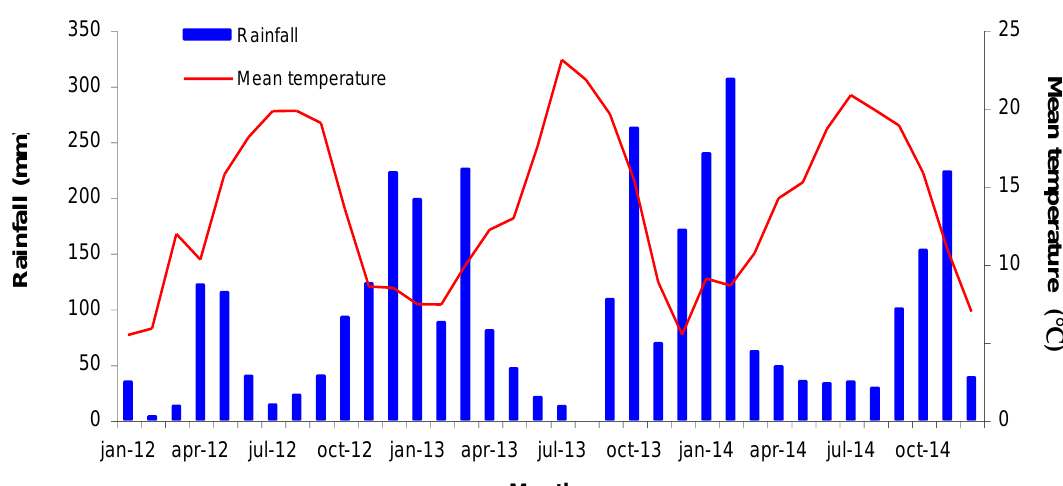
Figure 1. Monthly rainfall and mean temperature at the experimental vineyard over the three years studied (2012–2014).